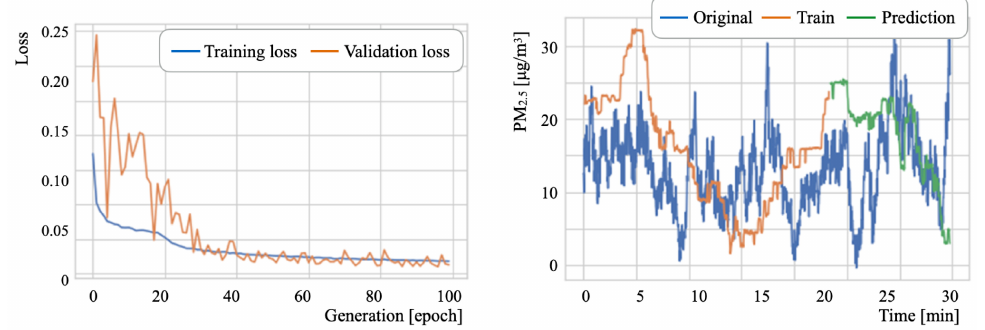
Figure 23. Loss curves and PM 2.5 prediction results for D2.